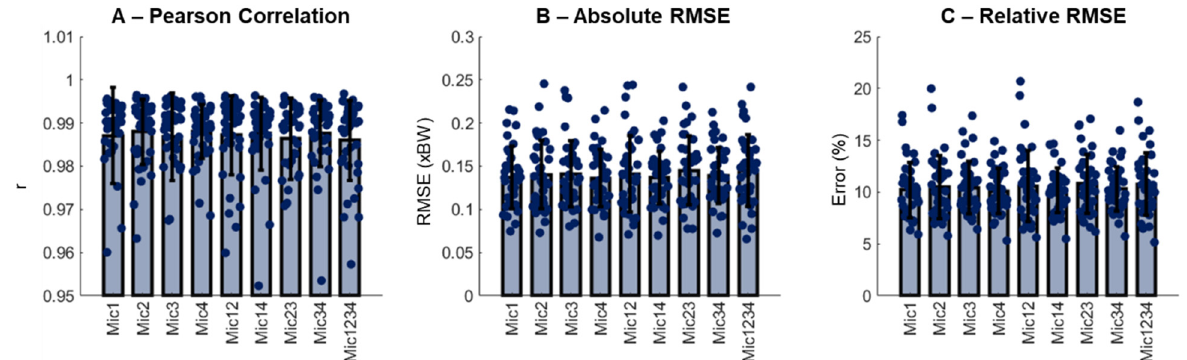
Figure 3. Mean (SD) and data distribution from the study sample (N = 37) of Pearson correlation coefficient (r, panel A ), absolute root ‐ mean ‐ square error (RMSE, panel B ), and relative RMSE (panel C ).